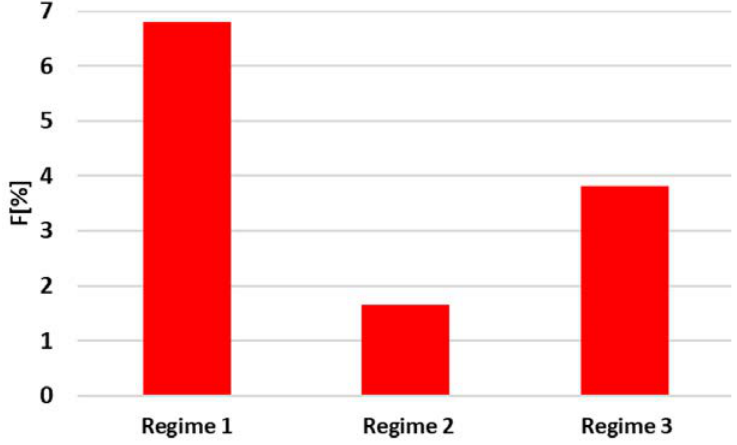
Figure 17. Variation of the engine thrust depending on the regime.